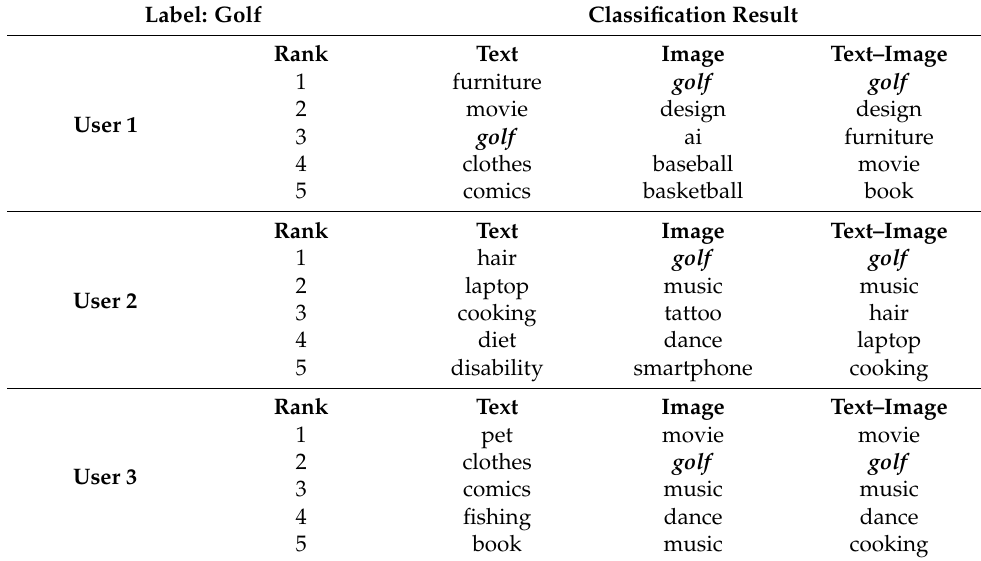
Table 4. Examples of classifying users’ interests. Label: Golf